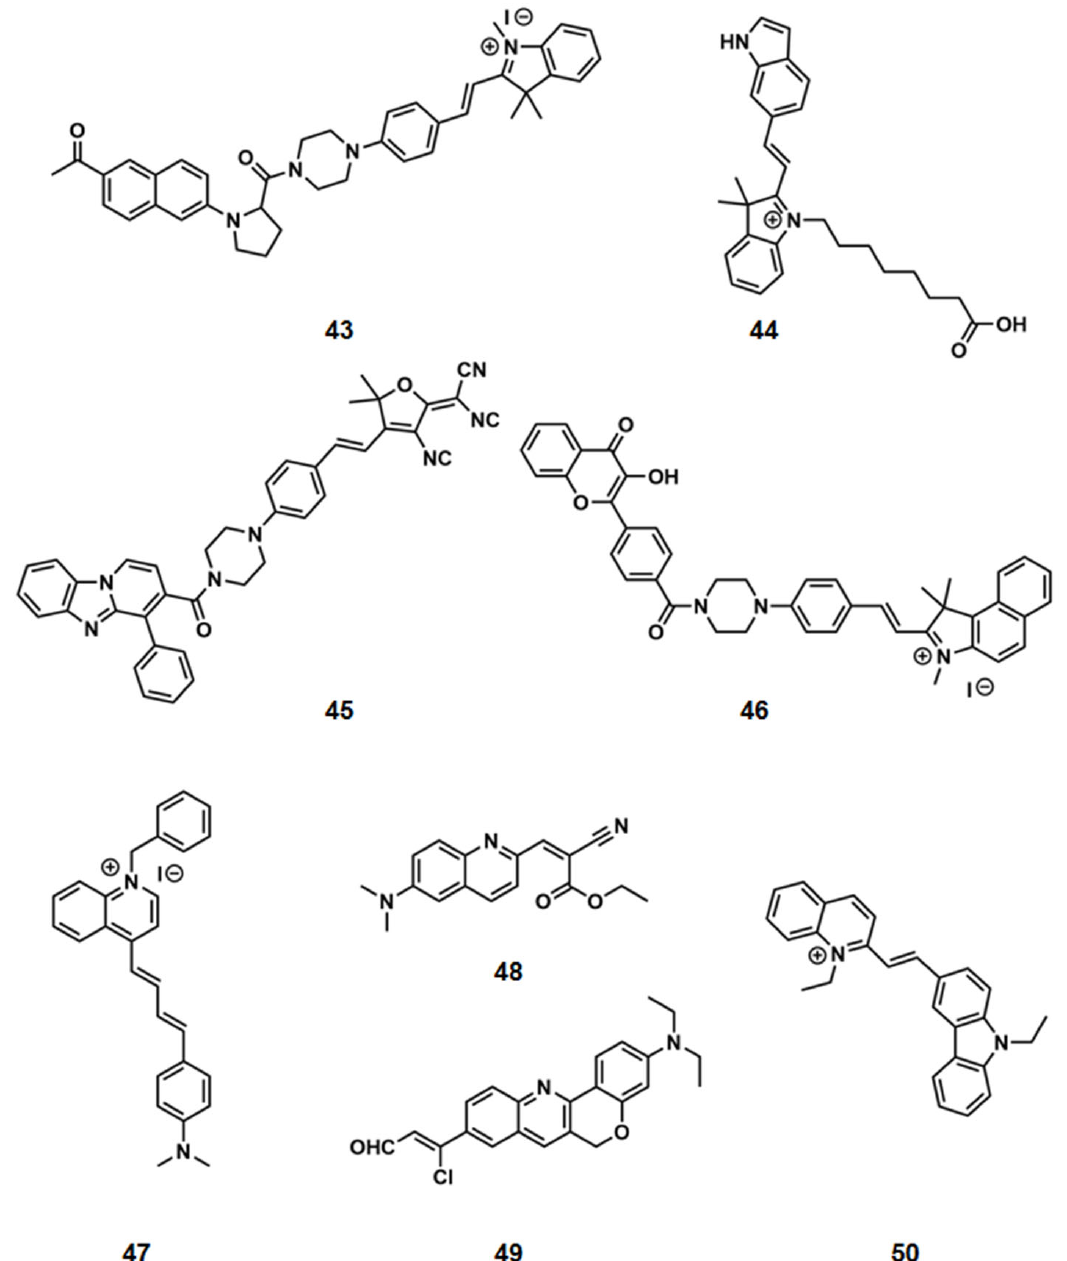
for 30 min; ( b ) 1 μ M SO 32 − for 30 min, 2 μ M probe 47 for 30 min; ( c ) 2 μ M SO 32 − for 30 min, 2 μ M probe 47 for 30 min; ( d ) 5 μ M SO 32 − for 30 min, 2 μ M probe 47 for 30 min; ( e ) 10 μ M SO 32 − for 30 min, 2 μ M probe 47 for 30 min. ( f ) Different normalized intensities toward different concentrations of SO 32 − , respectively. Red channel: λ ex = 552 nm λ em = 600–660 nm. Values are the means ± SD for each group of three exper